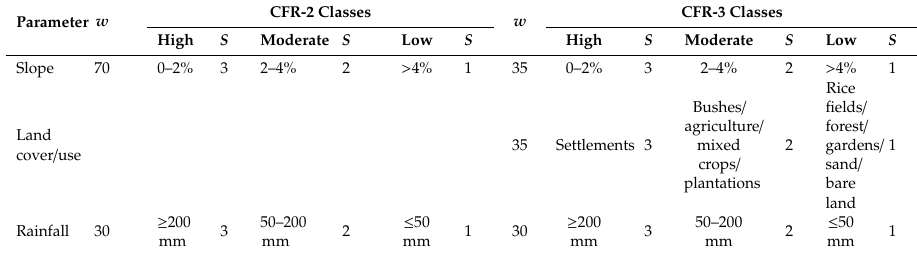
Rice Bushes / fields / agriculture / forest / mixed 2 gardens / 1 crops / sand / plantations bare land ≥ 200 50–200 mm